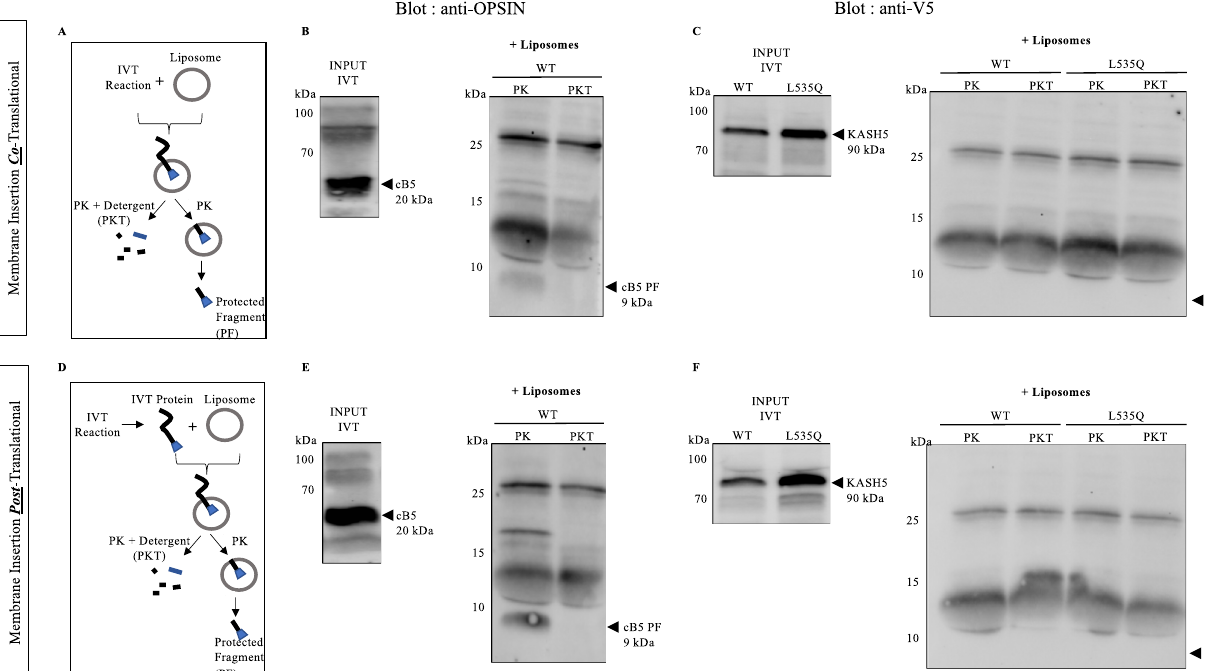
Figure 7. L535Q KASH5 does not insert spontaneously into protein-free liposomes. A protein-free liposome system was used to check for the spontaneous membrane insertion of L535Q KASH5. Liposomes were added either during the in vitro transcription/translation reaction [co-translational ( A )] or after the proteins were translated [post-translational ( D )]. Both samples were then subjected to proteinase K digestion in the presence or absence of TritonX100 detergent (PKT and PK, respectively). Co- or post-translational translocation assays were dissolved in loading buffer and subjected to immunoblot analysis with an anti-opsin or an